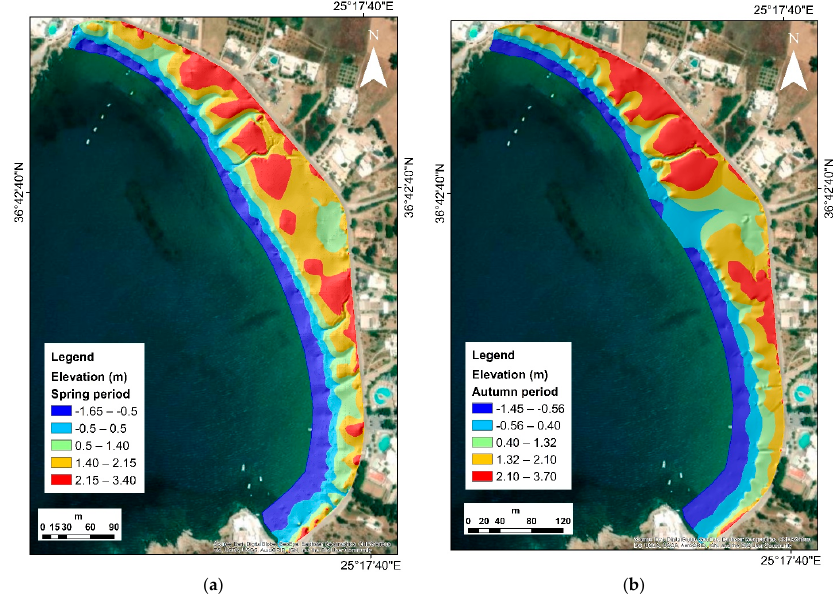
Figure 9. DEM of Mylopotas beach. ( a ) Shows the values of elevation from seaward to landward for the autumn period. ( b ) Shows the values of elevation from seaward to landward for the spring period.